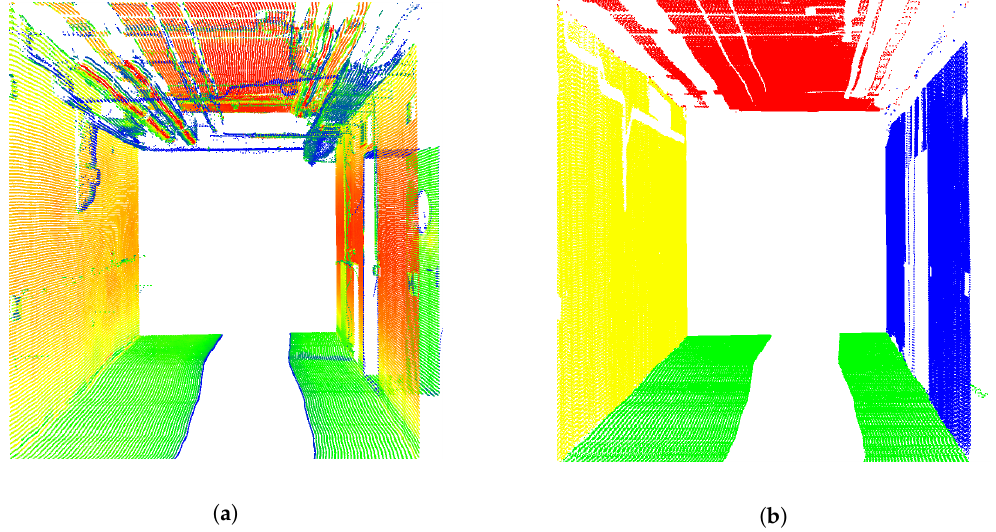
Figure 4. Georeferenced 3D point cloud of the environment measured based on the reference pose by means of laser tracker and T-Probe. Original scan points with colors by means of intensity ( a ). Assigned scan points regarding the left wall (yellow), right wall (blue), ceiling (red) and floor (green) ( b